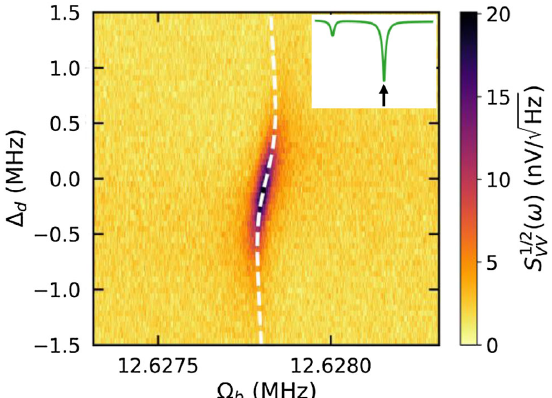
FIG. 4. Magnon-spring effect. Power spectral density of the mechanical motion within a partial pressure of helium gas and a constant probe power of 0.13 mW. The microwave drive was tuned to the normal mode shown in the inset. White curve is the theoretical prediction for the magnon-spring effect [37], where the only fit parameter was the intrinsic mechanical